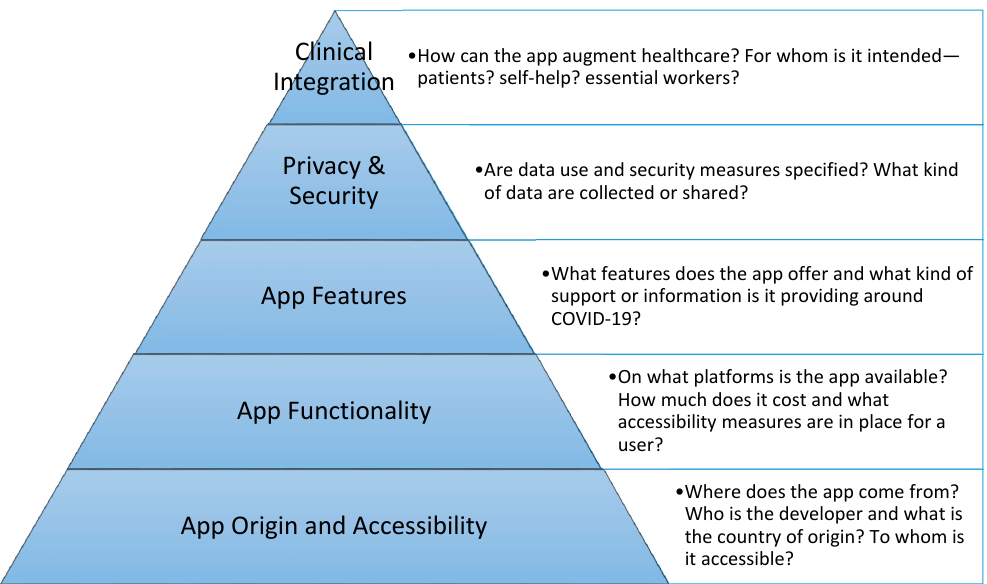
Figure 1. A Framework to Assess coronavirus disease 2019 (COVID-19)-Related Apps. Five main levels of consideration, with guiding questions at each level, illustrate the various facets of evaluation.